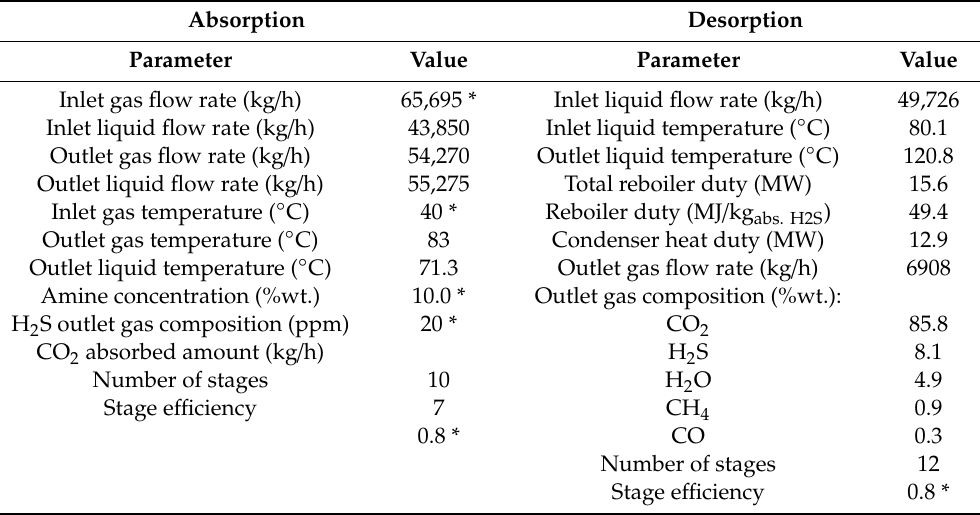
Table 10. Operating data and simulation results of MDEA acid gas absorber. * model input parameters. MDEA = N-methyl diethanolamine.